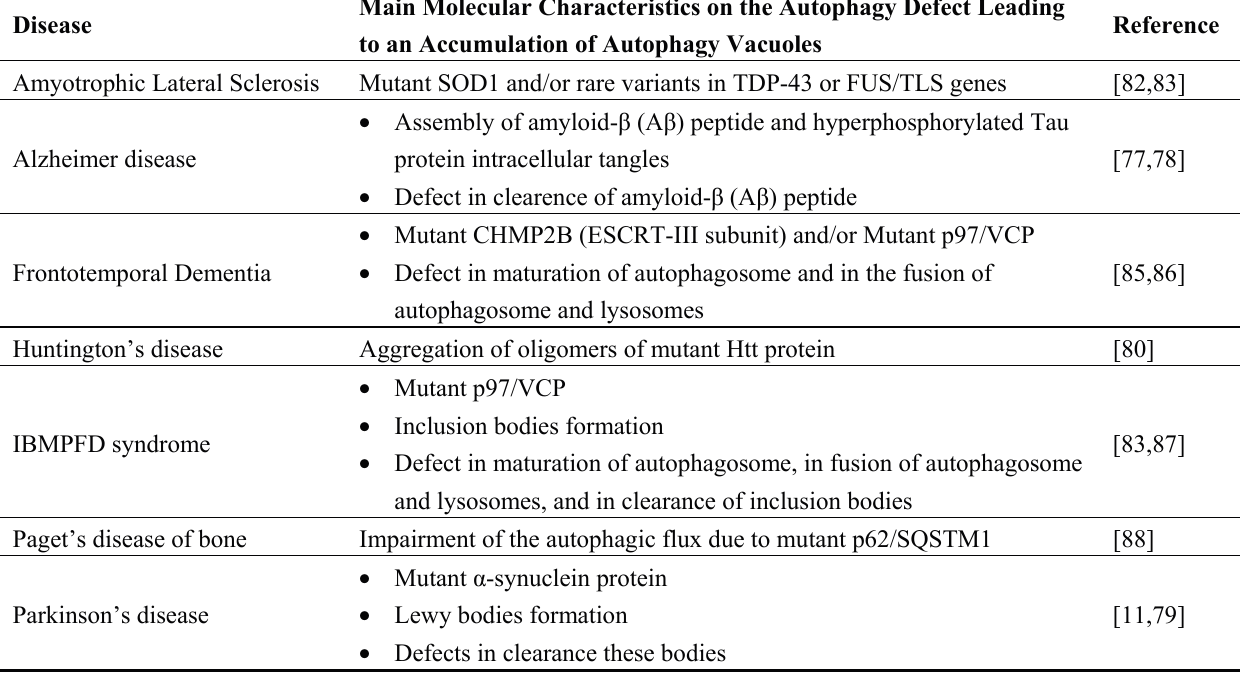
Table 2. Main molecular bases of autophagy defect in the most common autophagy-mediated aging